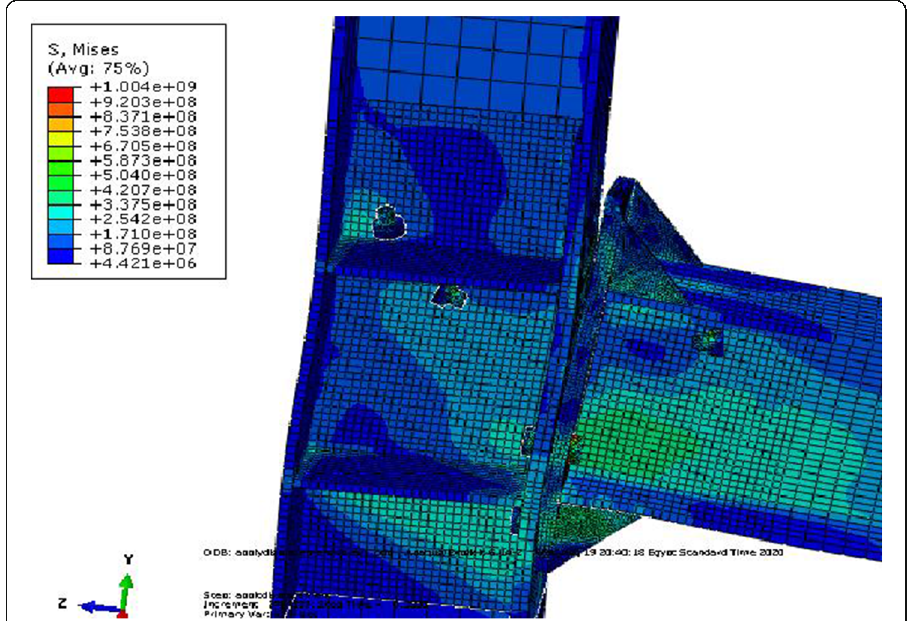
Fig. 20 Stress distribution for connection DR1 at